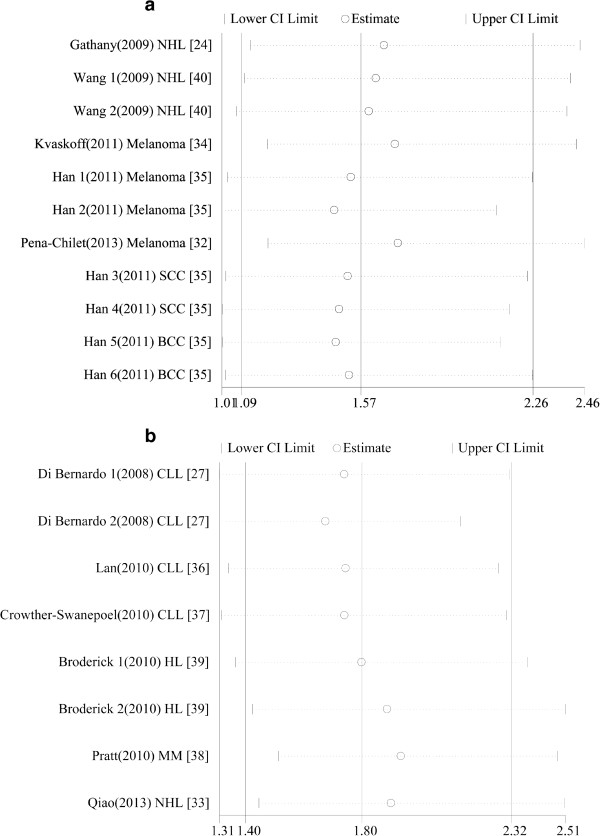
Results of the sensitivity analysis examining the association between the IRF4 and cancer risk polymorphisms and cancer risk in homozygote comparison model. (a). rs12203592, TT versus CC. (b). rs872071, GG versus AA.